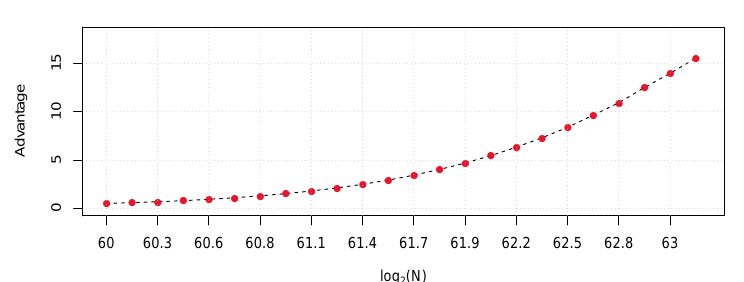
Figure 3: Advantage of the χ 2 distinguisher using 135 approximations of 22-round present , with P S = 0 . 95. At half the codebook, N = 2 63 , the advantage is 14.5